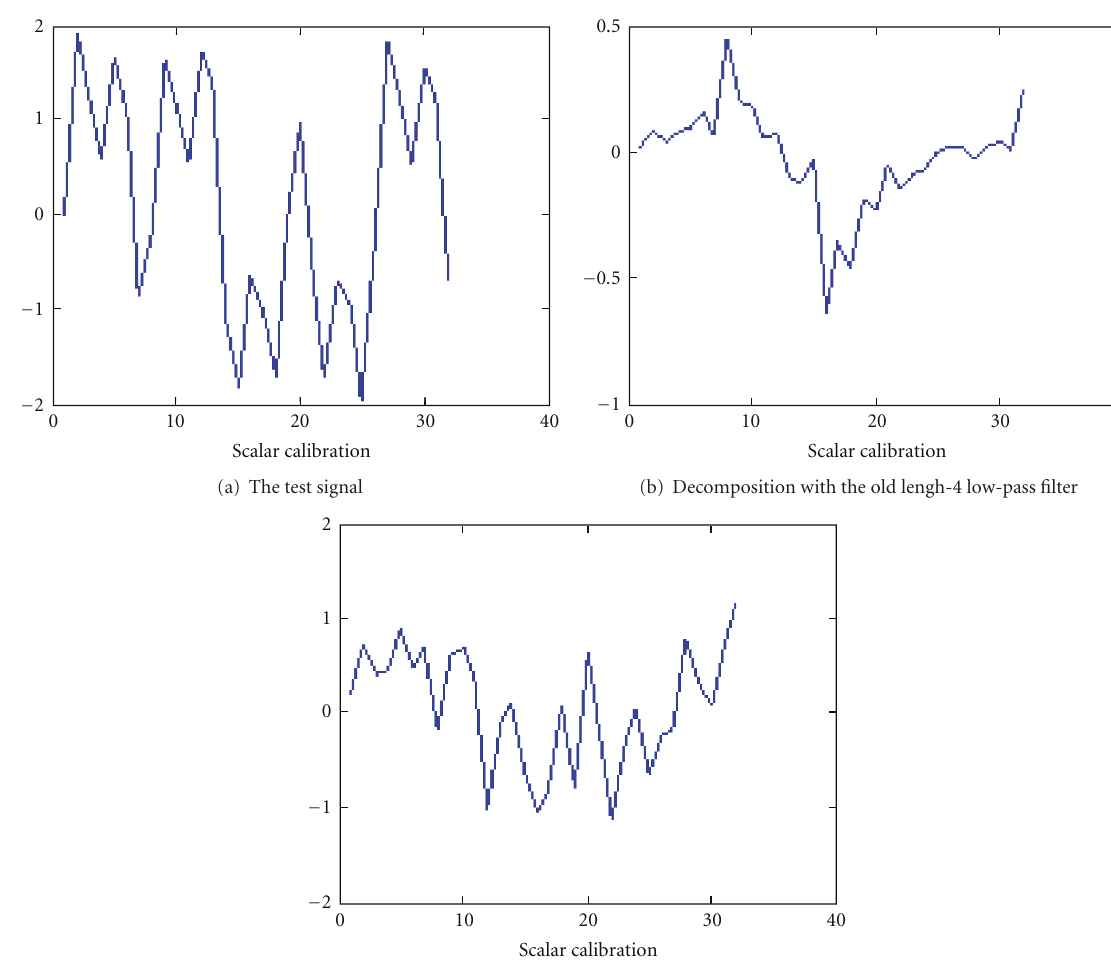
Figure 2: Decompositions of the test signal, prefiltered with Haar on interval [0, 40].